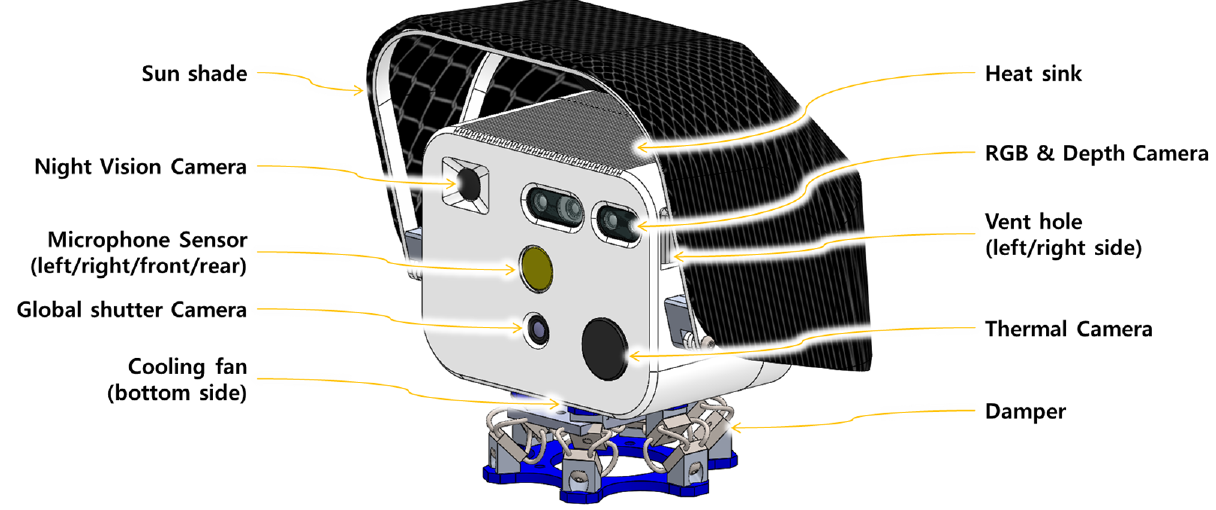
Figure 2. Multi-modal sensor system configuration.